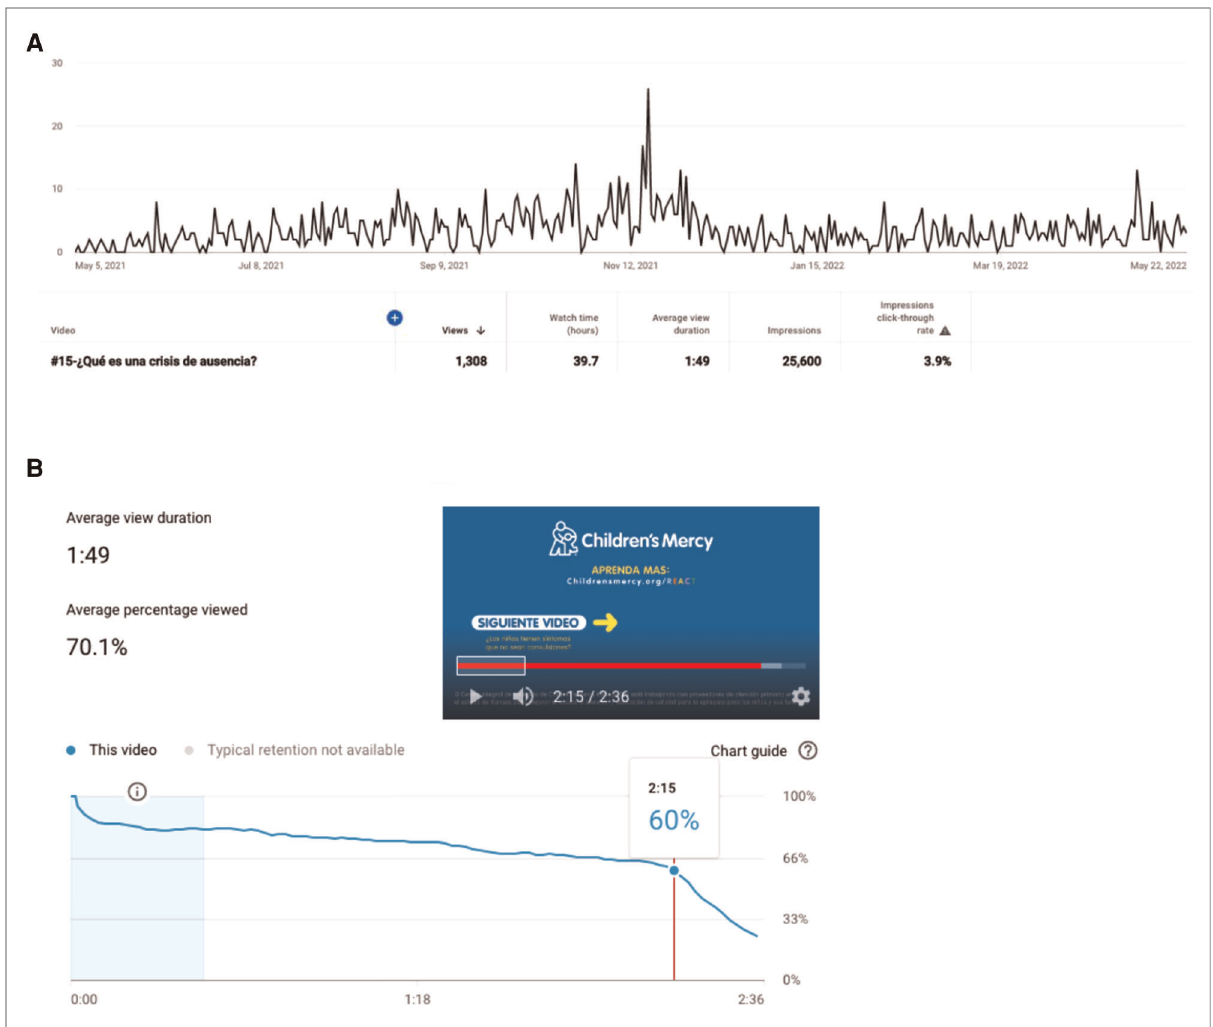
FIGURE 1 Example of a Spanish video analytics “ ¿Qué es una crisis de ausencia? ” (What is an absence seizure?). ( A ) Views of top viewed video. The height of each peak represents the number of views during the indicated day. ( B ) Video audience retention. Average video viewing duration, red line marks beginning of the